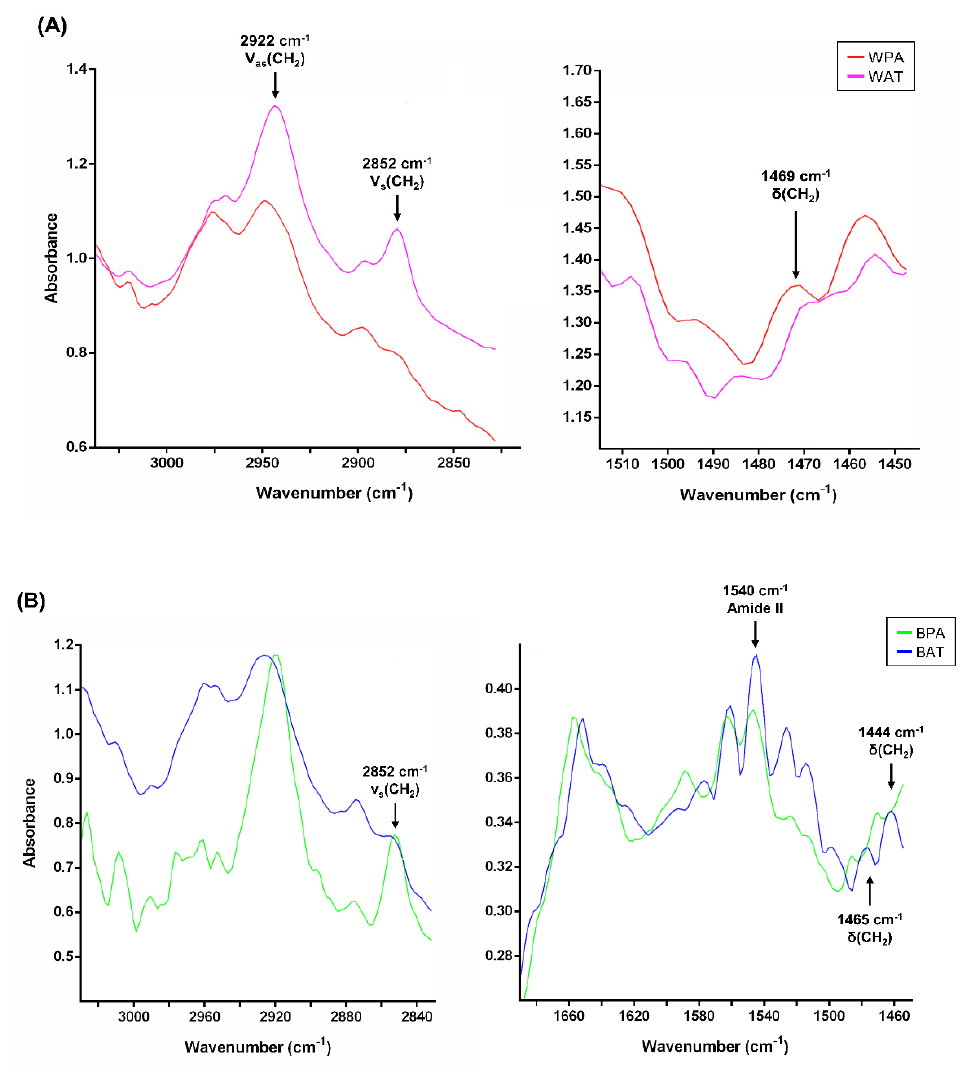
Figure 4. FTIR spectra from different types of adipocytes. ( A ) WPA (red), WAT (pink), ( B ) BPA (green), BAT (blue).